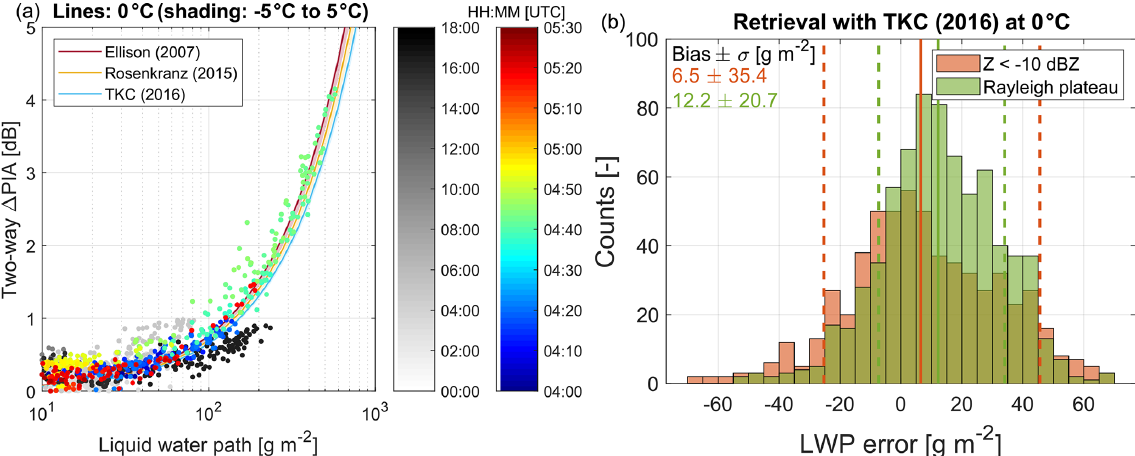
Figure 6. (a) Scatterplot of two-way (cid:49) PIA retrieved using the Rayleigh plateau technique as a function of the LWP measured by the MWR for the entire case study (color of the circles denotes the time in UTC). (b) Statistics (probability density function, bias, and standard deviation) of the retrieved LWP for the zoomed period of Fig. 5 using the Turner et al. (2016) model at 0°C for the traditional reflectivity threshold and the Rayleigh plateau method using the MWR as a